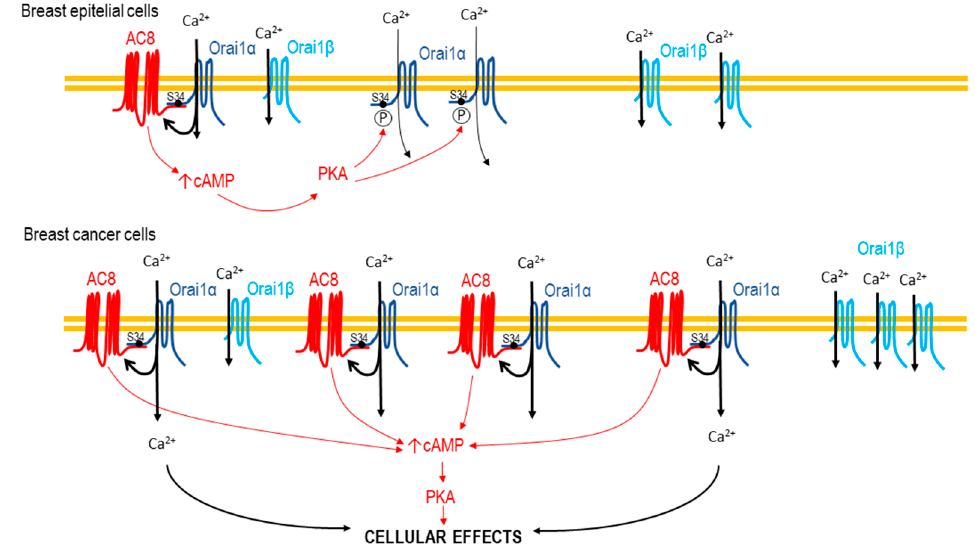
Figure 12. Cartoon summarizing the impairment of phosphorylation-dependent Orai1 inactivation by AC8 overexpression. In non-tumoral breast epithelial cells, Ca 2+ influx via Orai1 activates AC8, which, in turn, results in the activation of PKA, leading to inactivation of a large subset of AC8-independent Orai1 channels. In breast cancer MDA-MB-231 cells, the greater AC8 overexpression modifies the AC8 / Orai1 stoichiometry, thus preventing phosphorylation-dependent Orai1